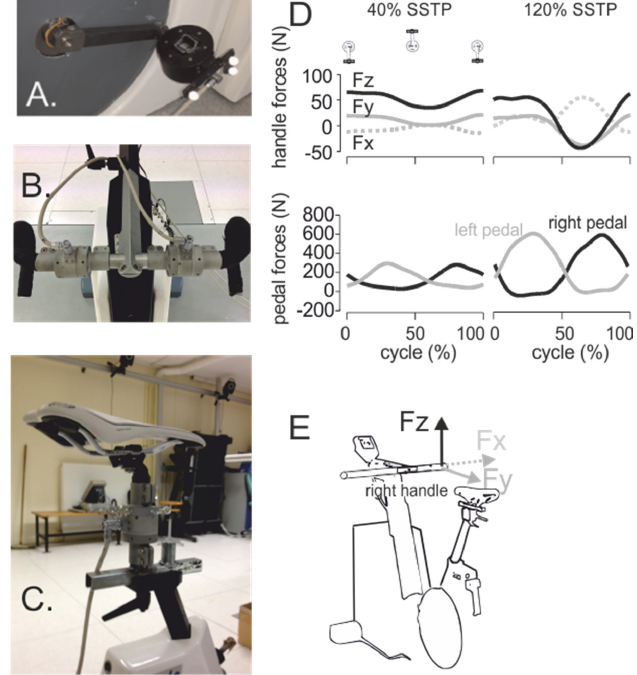
Figure 3. Force sensors. Panels ( A – C ) show force sensors at the pedal, handlebar and saddle. These were designed by Sensix, Poitiers, France. The sensors allow the measurement of forces and moments in three dimensions at the three points of interaction between the ergometer and the cyclist. Panel ( D ) shows the forces produced at the right handlebar and the pedals when pedaling in a seated position at two intensities: 40% of the seat-to-stand transition power (SSTP) and 120% of the SSTP, which represent approximately 200 W and 600 W, respectively (at 90 RPM). Note the decrease in the Fz component during the right downstroke, which goes from positive (pushing) to negative (pulling) between 40% and 120% SSTP. Panel E provides the direction of the handle forces in Three